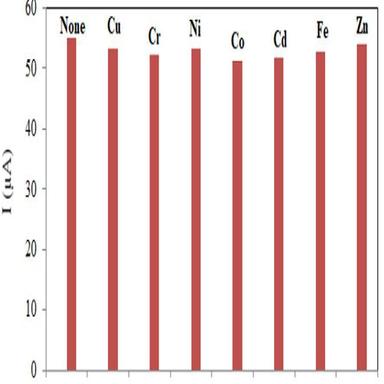
Influences of some typical metal ions on the peak currents of Pb(II) in 0.1 M acetate buffer (pH 5.0) at the GO-imi- (CH2)2-NH2 /CPE.